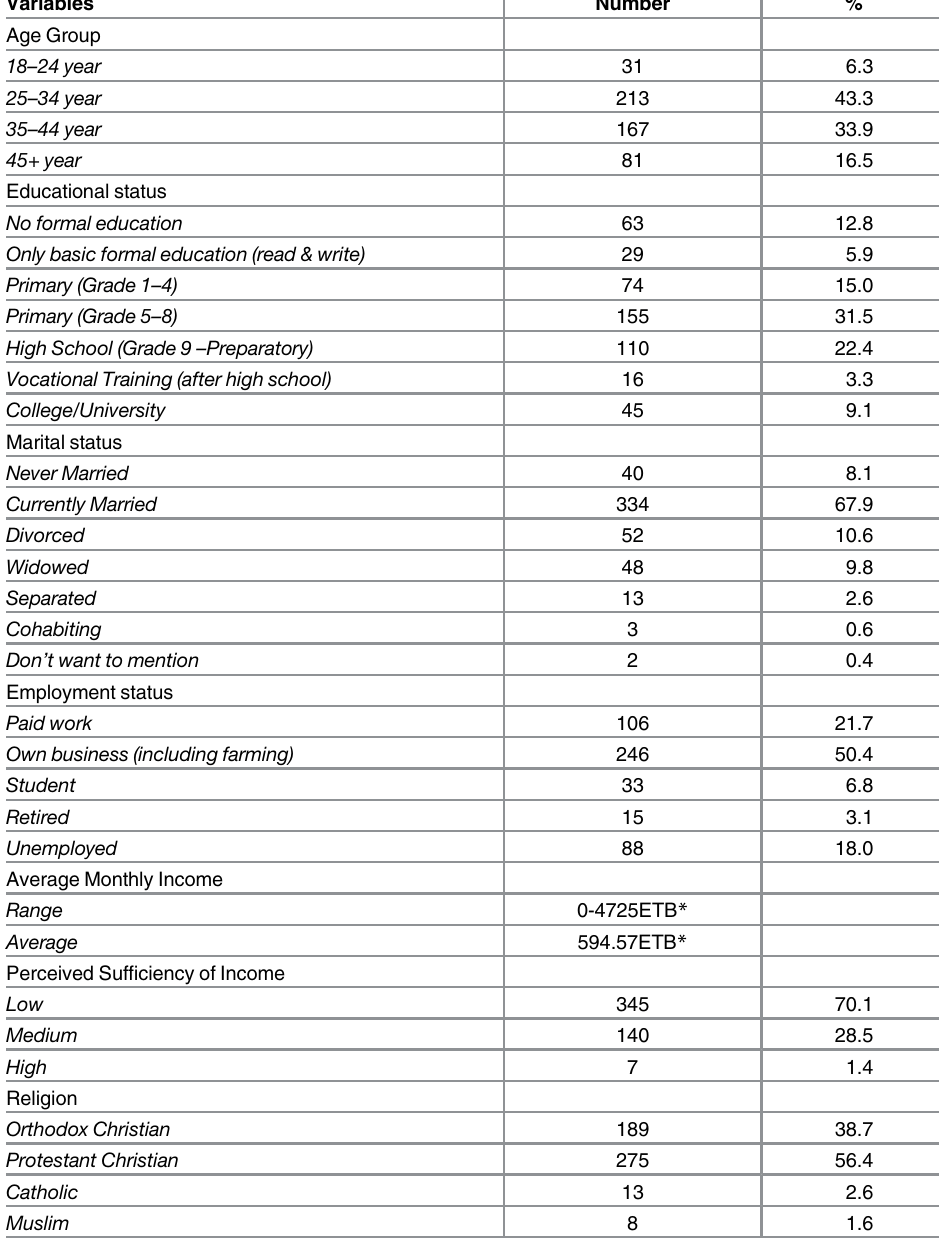
Table 1. Socio-demographic characteristics of participants, Wolaita Zone, Ethiopia, 2015.